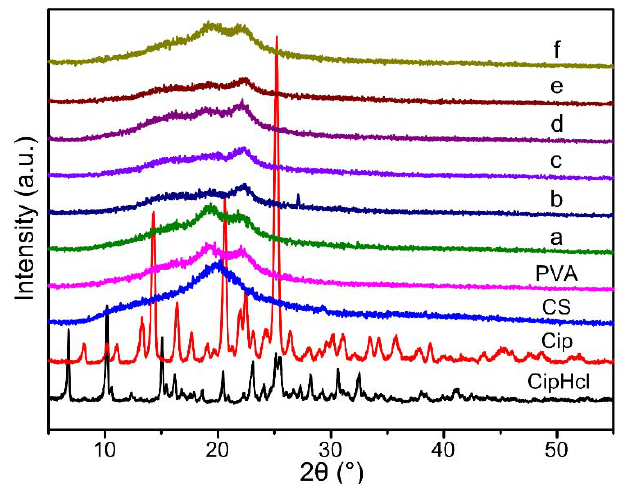
Figure 3. X ‐ ray diffraction (XRD) diffraction patterns of pure CS powder, pure PVA nanofibrous Figure 3. X-ray di ff raction (XRD) di ff raction patterns of pure CS powder, pure PVA nanofibrous membrane, Cip powder, CipHcl powder and drug ‐ loaded nanofibrous membranes: ( a ) CS/PVA membrane, Cip powder, CipHcl powder and drug-loaded nanofibrous membranes: ( a ) CS / PVA nanofibrous membrane, ( b ) CS/PVA/GO nanofibrous membrane, ( c ) CS/PVA/CipHcl nanofibrous nanofibrous membrane, ( b ) CS / PVA / GO nanofibrous membrane, ( c ) CS / PVA / CipHcl nanofibrous membrane, ( d ) CS/PVA/GO/CipHcl nanofibrous membrane, ( e ) CS/PVA/Cip nanofibrous membrane, ( d ) CS / PVA / GO / CipHcl nanofibrous membrane, ( e ) CS / PVA / Cip nanofibrous membrane, membrane, ( f ) CS/PVA/GO/Cip nanofibrous membrane. ( f ) CS / PVA / GO / Cip nanofibrous